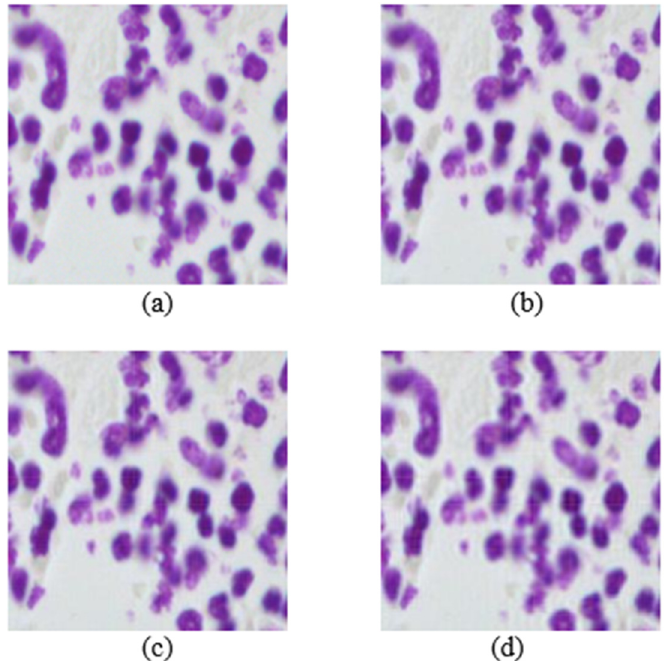
Figure 3. Images from the nuclei cell dataset. ( a ) Original image. Mb-Ada with order, ( b ) 200, ( c ) 120, ( d ) 80.